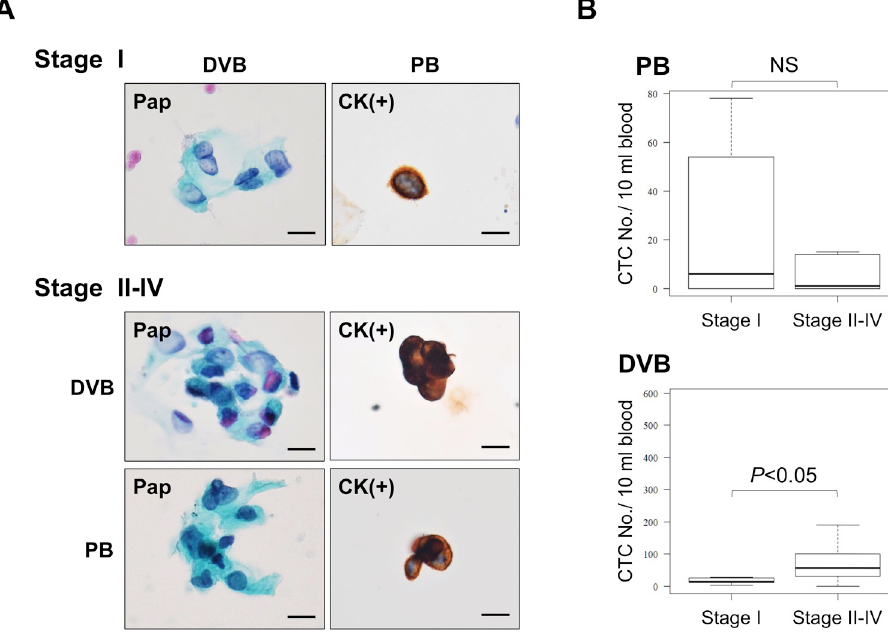
Fig 6. Numbers of CTCs in PB and DVB from CRC patients in relation to the tumor stage (I–IV). (A) Representative CTCs stained by Pap and cytokeratin ICC from patients with stage I (upper) and stage II–IV CRC (lower). Bar = 10 μ m. (B) Numbers of CTCs in PB and DVB from CRC patients according to stage. p < 0.05 (Stage I vs Stage II–IV) for DVB. NS (= not significant) for PB. Bars = standard deviation (SD).